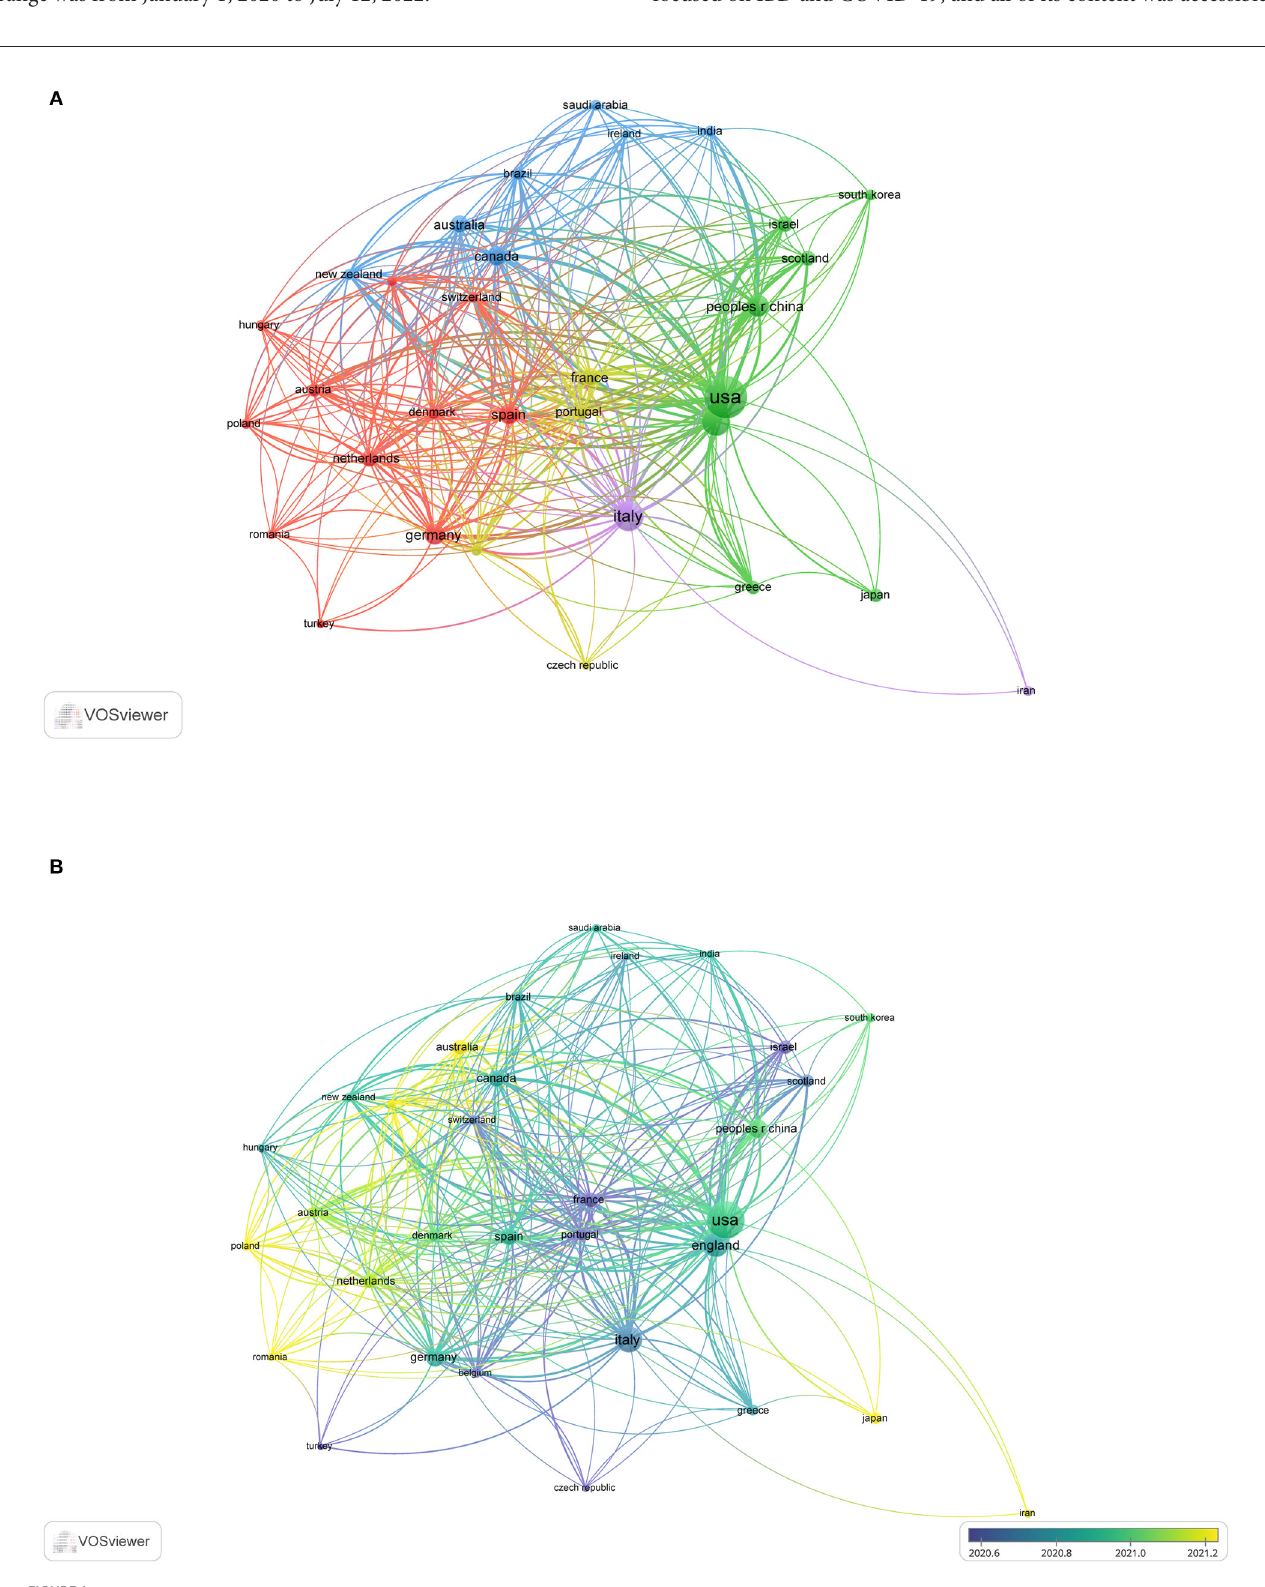
FIGURE1 The cooperative countries in the field of IBD and COVID-19. (A) The top 32 most cooperative countries. (B) Time sequence chart of cooperative countries.